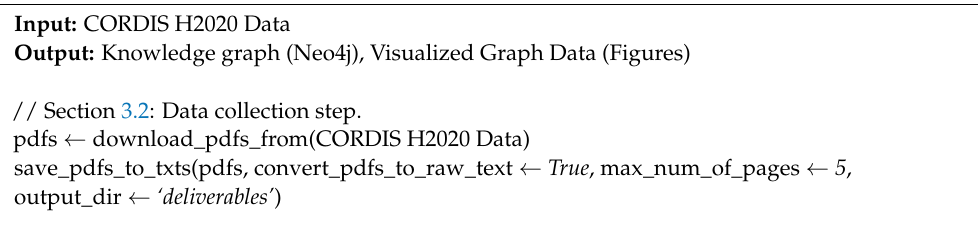
Algorithm A1. Pseudocode of the Proposed